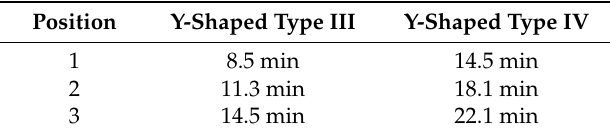
Table 4. Solidification times in the positions shown in Figure 5 obtained from the numerical analysis. The value read at the node in the center of each sample was considered.